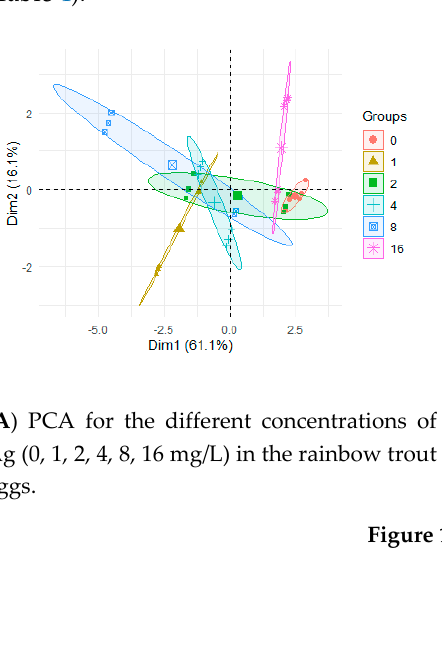
Table 3. PERMANOVA analysis of the factors (chemical compound, concentration, life stage, and their combinations) a ff ecting the Ag concentration in the fry and eggs of rainbow trout.